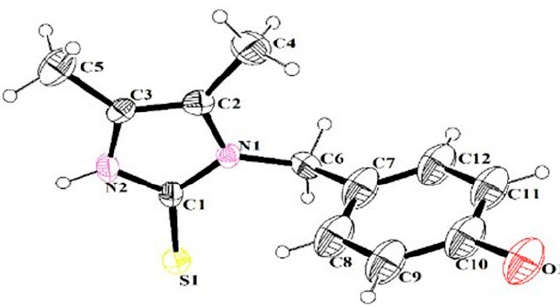
Figure 5. ORTEP diagram of Compound 2